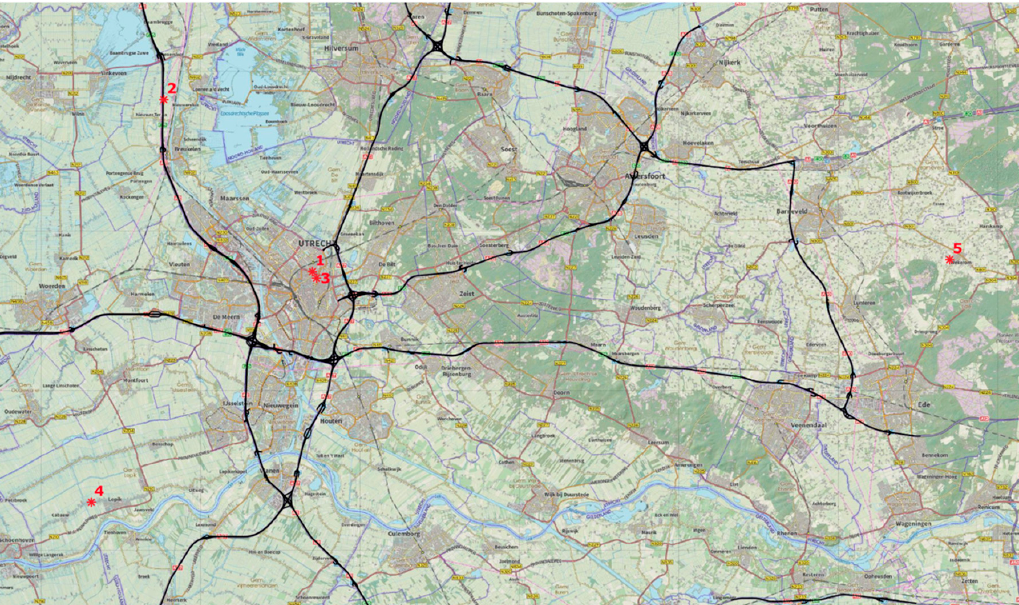
Figure 1. Area of the province of Utrecht. The “*” markers indicate the locations of official air quality measurements (PM 2.5 ) at Kardinaal de Jongweg (1), Breukelen (2), Griftpark (3), Cabauw (4) and Wekerom (5). Source map: pdok.nl (accessed on 25 May